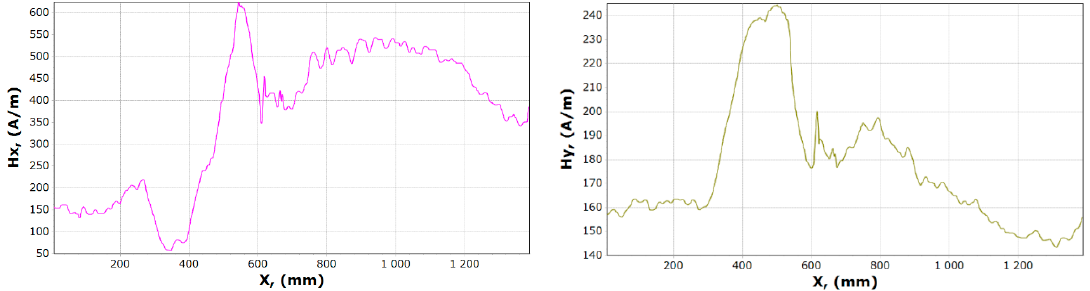
Figure 8. Graphs of tangential Hx and normal Hy component of the magnetic field, for sample 1.